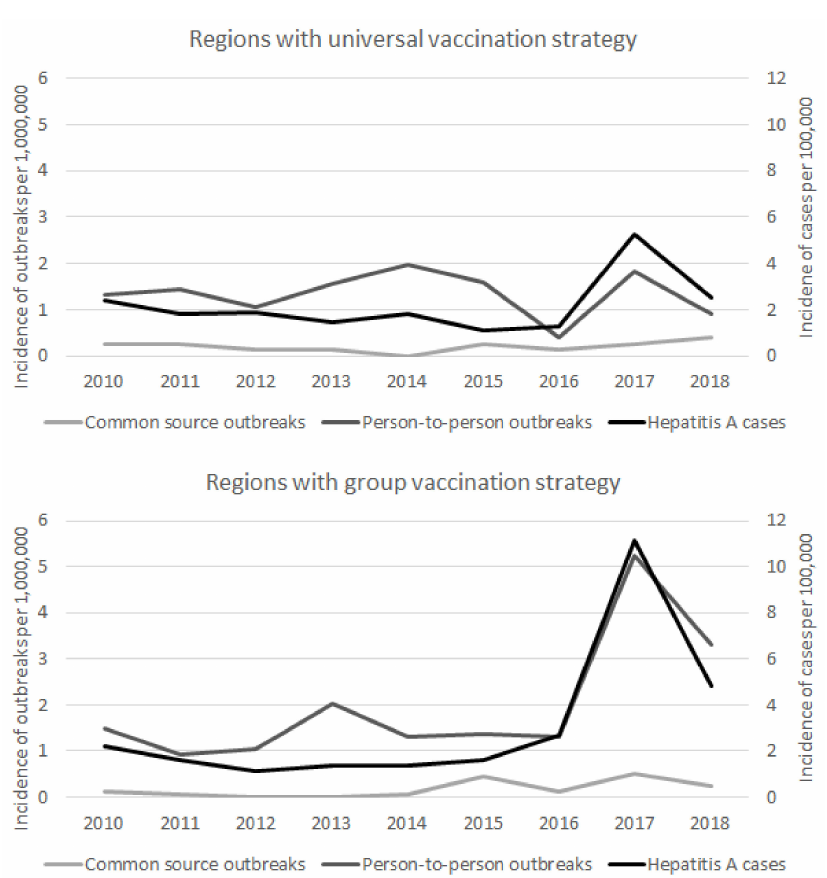
Figure 1. Annual incidence rate of hepatitis A cases and hepatitis A outbreaks according to transmis- sion mode by vaccination strategy. Spain, 2010–2018. Common source outbreaks were non-significantly more frequent in regions with universal vaccination (13.2%) than in those with risk-group vaccination (7.9%) (Table 2).